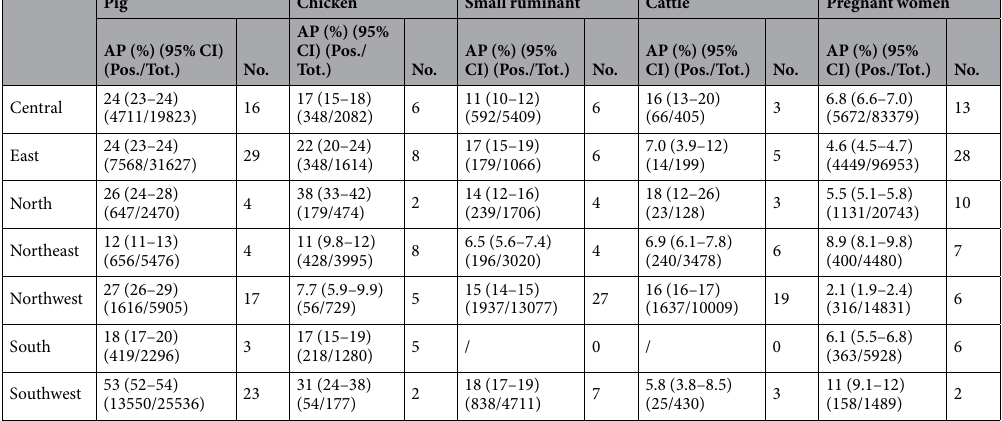
Table 1. Non-modelled apparent seroprevalence (%) of pregnant women and livestock in mainland of China. AP: apparent prevalence; Pos.: number of seropositive animals; Tot.: number of tested animals; No.: number of records.